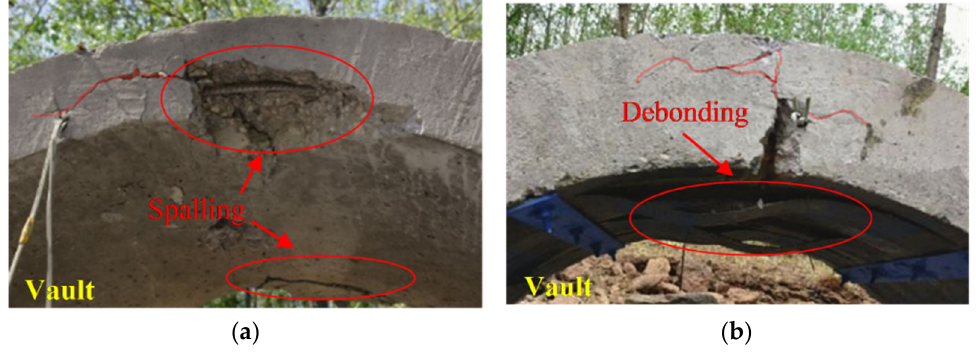
Figure 8. Anti-explosion damages of arches ( a ) A1, and ( b ) A4 [5]. Arch A4 uses steel plate battens to anchor the bonded CFRP sheets. Due to the impact effect, the steel plate exactly fell off and the CFRP sheets debonded, the bolts were pulled